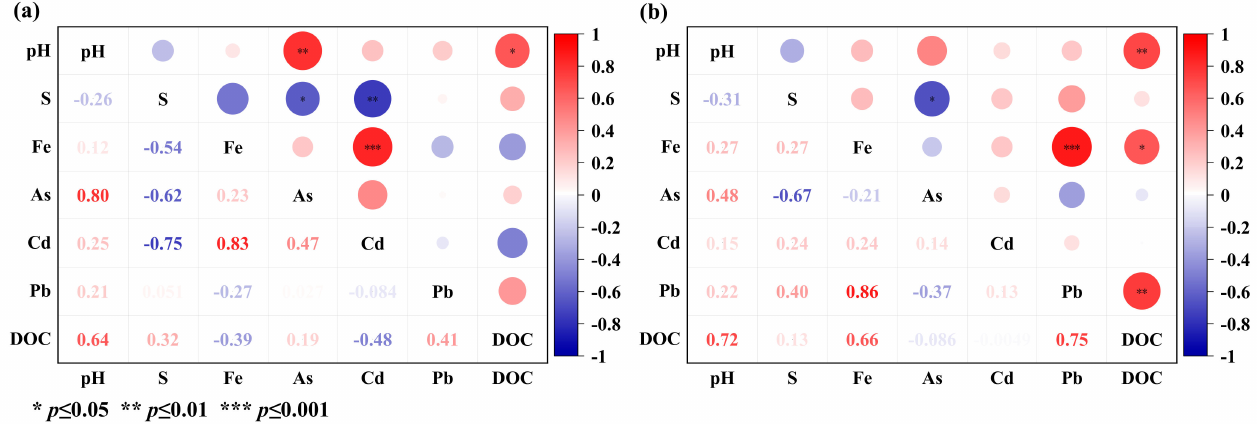
Figure 5. Correlation between physical and chemical properties of soil and bioavailability of Cd, Pb, and As in the vertical soil column. ( a ): CK; ( b ):